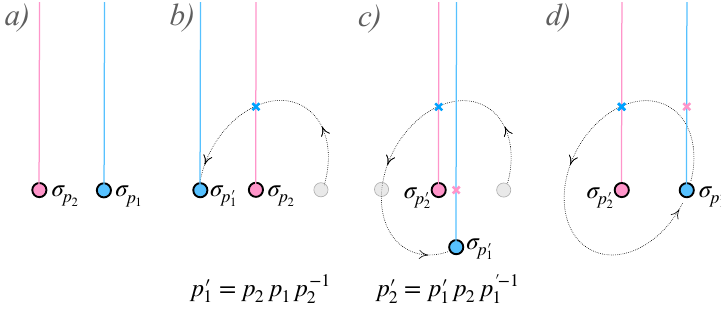
Figure 1 . Moving twist operators on S 2 Whenever a twist crosses a branch cut, its permutation